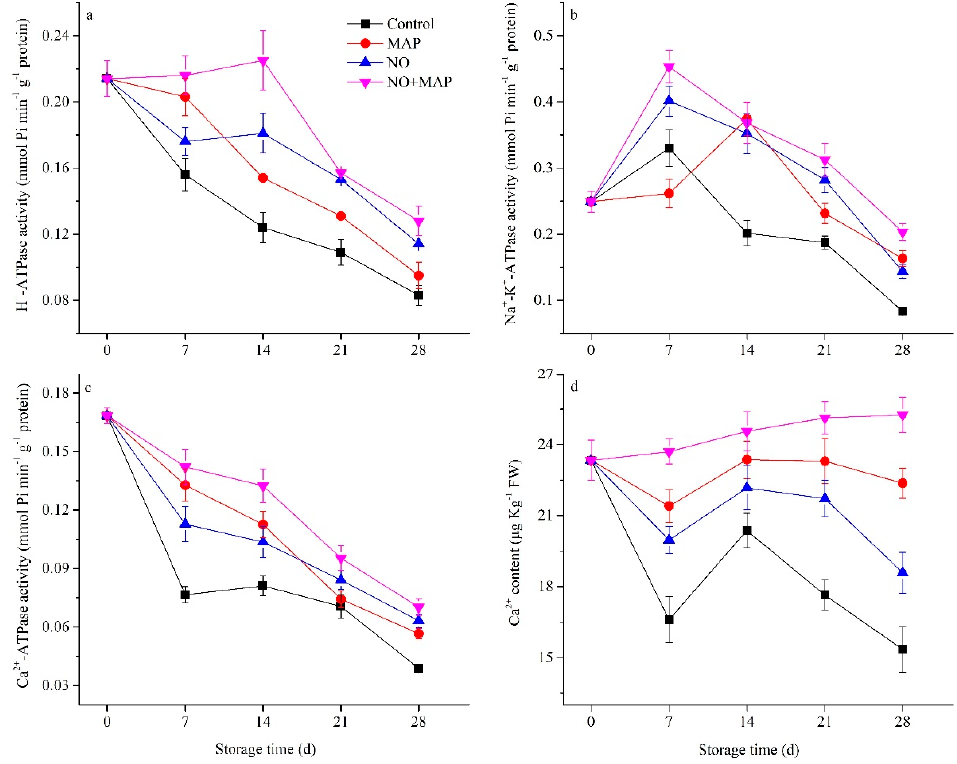
Figure 5. Effects of NO and MAP treatment on activities of H + -ATPase ( a ), Na + -K + -ATPase ( b ), Ca 2+ -ATPase ( c ), and Ca 2+ content ( d ) in water bamboo shoots stored at 4 °C for 0, 7, 14, 21, and 28 d. Values are presented as mean ± SD.